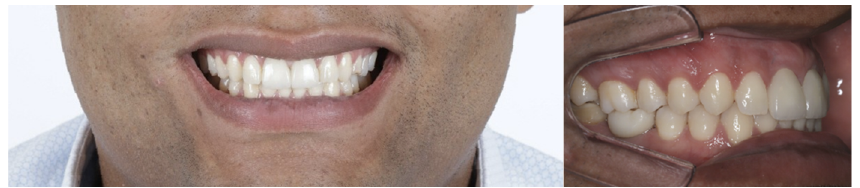
Figure 14. Frontal and lateral view of 3-year follow-up, showing the permanence of tissue stability.